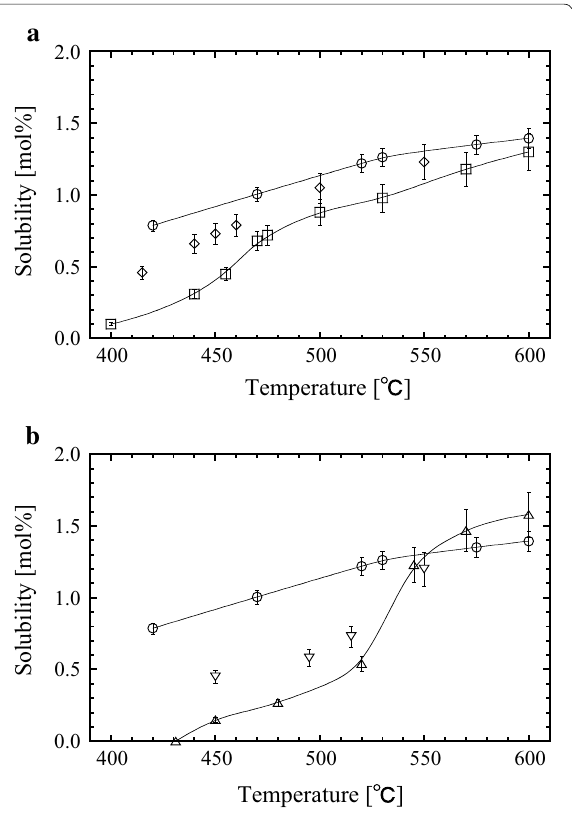
Fig. 2 Temperature dependence of GaN solubility in supercritical ammonia with different mineralizers (100 MPa, 3.1 NH 4 Cl, circle (from previous work [18]); NH 4 Br, square (from previous work [12]); NH 4 I, triangle (from previous work [12]); NH 4 Cl (equal mole ratio), rhombus (present study); NH 4 Cl mole ratio), nabla (present study): a NH 4 Cl, NH 4 Br, NH 4 Cl NH 4 Cl, NH 4 I, NH 4 Cl NH 4 +